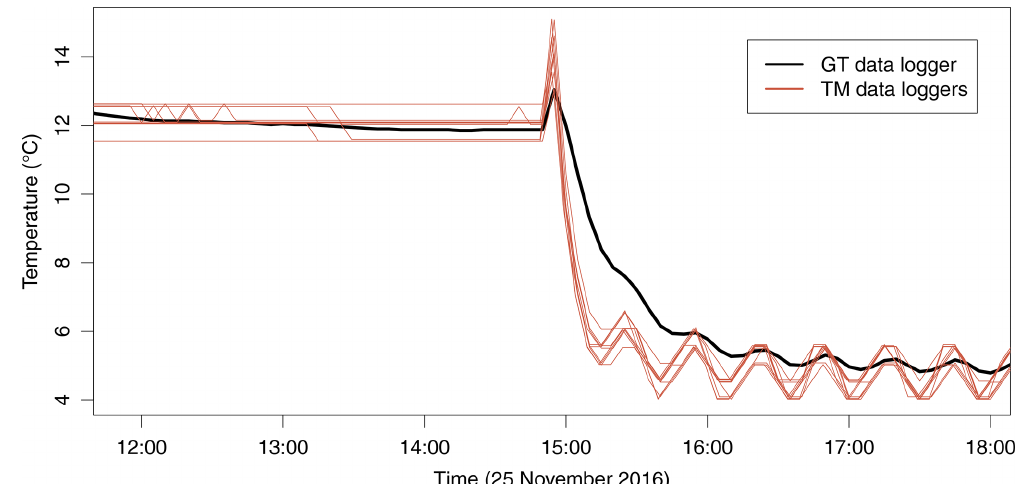
Figure A1. Comparative measurement of the TM data loggers with a high-quality GT data logger as a reference. The experiment was conducted over 6h at 4 and 12 ◦ C in a fridge in the lab. The sampling interval was 15min. Note that the GT data logger has a longer response time than the TM data loggers as it was designed primarily for measuring ground temperatures and not ambient air temperatures. The offset between the TM data loggers and the GT data logger is less than the measuring accuracy of the TM loggers ( ± 0.5 ◦ C at − 10 to 65 ◦ C).